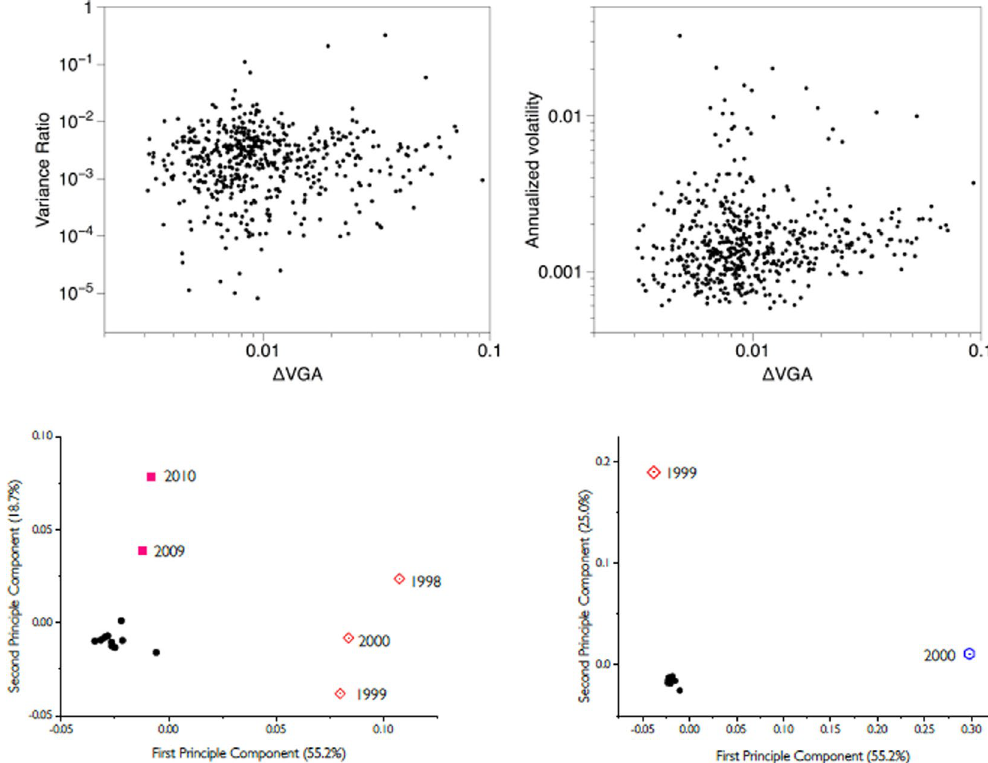
Figure 7. (Upper panels) Scatter plot of the Δ VGA (HVG) versus Variance Ratio (left panel) and annualized volatility (right panel) for each year in the period 1998–2012 for the set of 35 companies in the dataset ( N = 525 samples). No obvious correlation shows up (Pearson correlation r = 0.085 and 0.032 respectively). (Bottom, Left 19982012 where d is the distance between the top and bottom degree panel) PCA on the space = d { (year)} c year distributions (each point is a 35-dimensional vector describing the financial state of a given year in the PCA space spanned by the distance of top vs bottom degree distributions, for each of the 35 stock prices). Here we project points in the 2-dimensional space spanned by the first two principal components. We can see how three clusters emerge naturally: one agglomerating the years 1998,1999,2000 (which coincide with the.com bubble), one agglomerating 2009,2010 (coinciding with the period of the global financial crisis), and another cluster with the rest of the years (which coincide with periods of relatively stable financial activity). (Bottom, Right panel) 19982012 , where the feature extracted from each stock Equivalent PCA projection on the space | | = V R { log( ) } c (year) year price is now |log( V R )|. We find that this feature is less informative. Accordingly, we therefore interpret that the difference between local maxima and local minima are not simply related to differences between marginal distributions, but a difference in the correlation (temporal ordering)